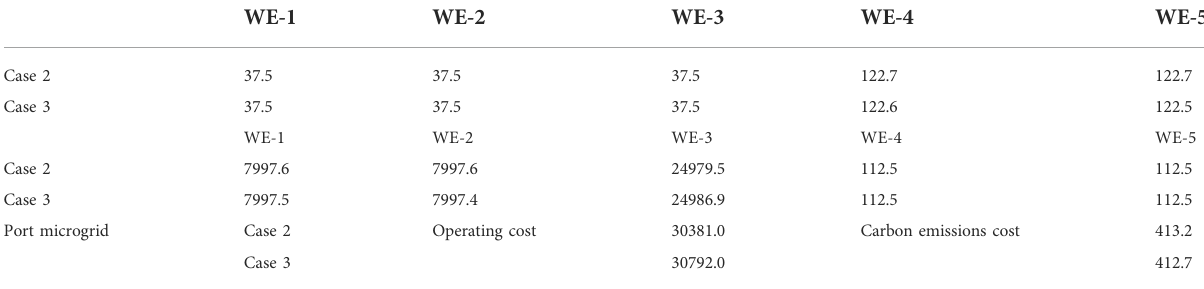
TABLE 3 Operating data of WEs by using the distributed